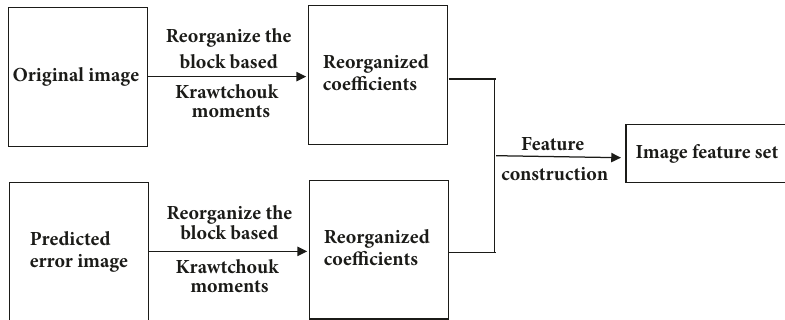
Figure 1: Proposed image feature generation procedure.